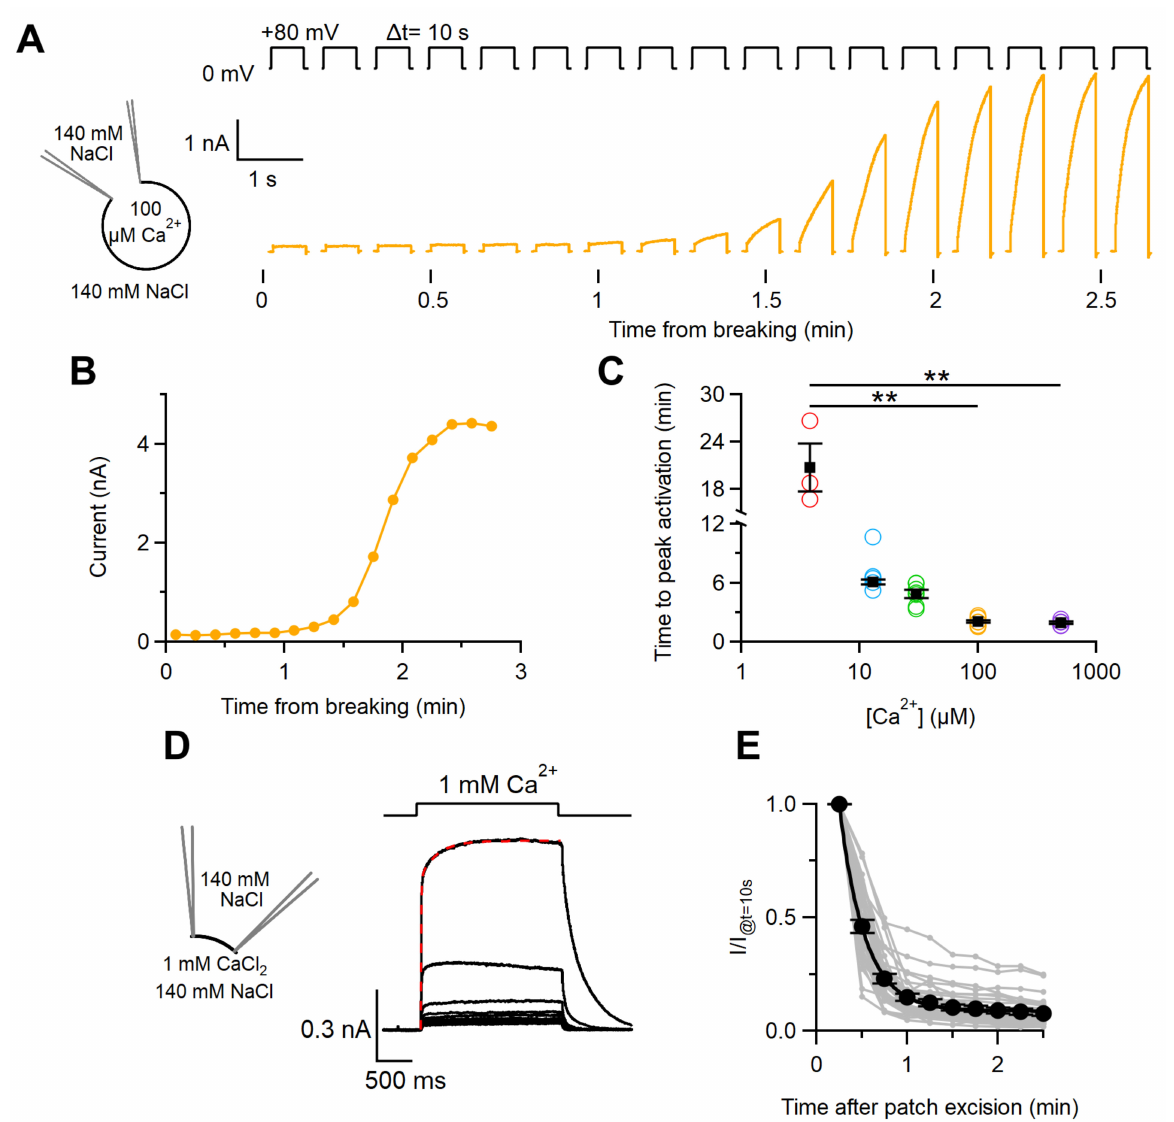
Figure 1. Kinetics of Ca 2+ -dependent activation of the TMEM16F wt-mediated current. ( A ) Whole-cell recordings obtained from TMEM16F wt-transfected cells with a pipette solution containing 100 µ M Ca 2+ . The development of the current with time was monitored by repeatedly applying a +80 mV step every 10 s, as indicated in the upper traces. ( B ) Current amplitudes at the end of voltage steps were plotted against the time after membrane breaking for the recordings in ( A ). ( C ) The time required to obtain the maximal current activation was plotted against the intracellular Ca 2+ concentration (n = 3–8, ** p < 0.01 Dunn–Holland–Wolf test after Kruskal–Wallis test). ( D ) An inside-out excised membrane patch expressing TMEM16F wt was repeatedly stimulated every 15 s with a solution containing 1 mM Ca 2+ as indicated in the upper trace. The holding potential was +60 mV. The red line superimposed to the upper trace is the fit with a double exponential function. ( E ) Ratios between the peak current values measured at various times after patch excision and the value measured after 10 s were plotted against the time after patch excision for several patches (grey dots and lines). Black circles are the average ± sem from different patches (n = 31). The black line is the best fit to a single